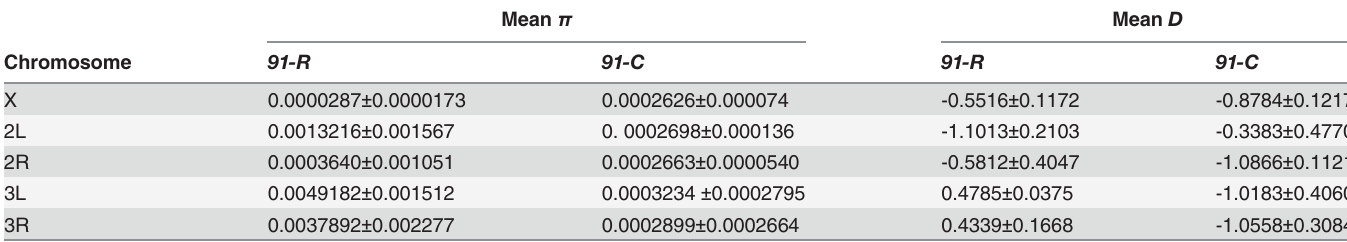
Table 1. Mean nucleotide diversity (pi; π ) and Tajima's D ( D ) among chromosome arms for DDT resistant 91-R and susceptible 91-C Drosophila melanogaster strains.